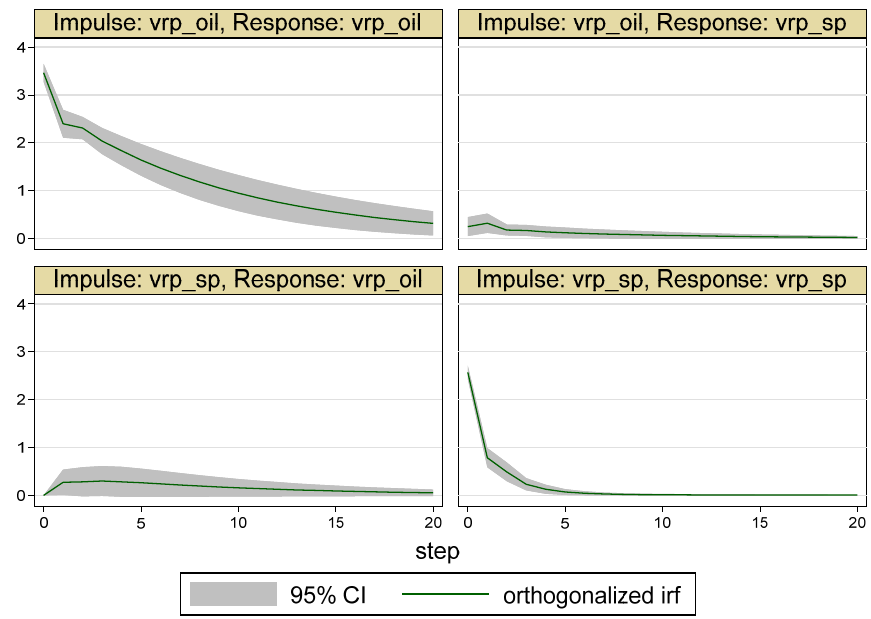
Figure 7. Impulse Response Function (Period 4).